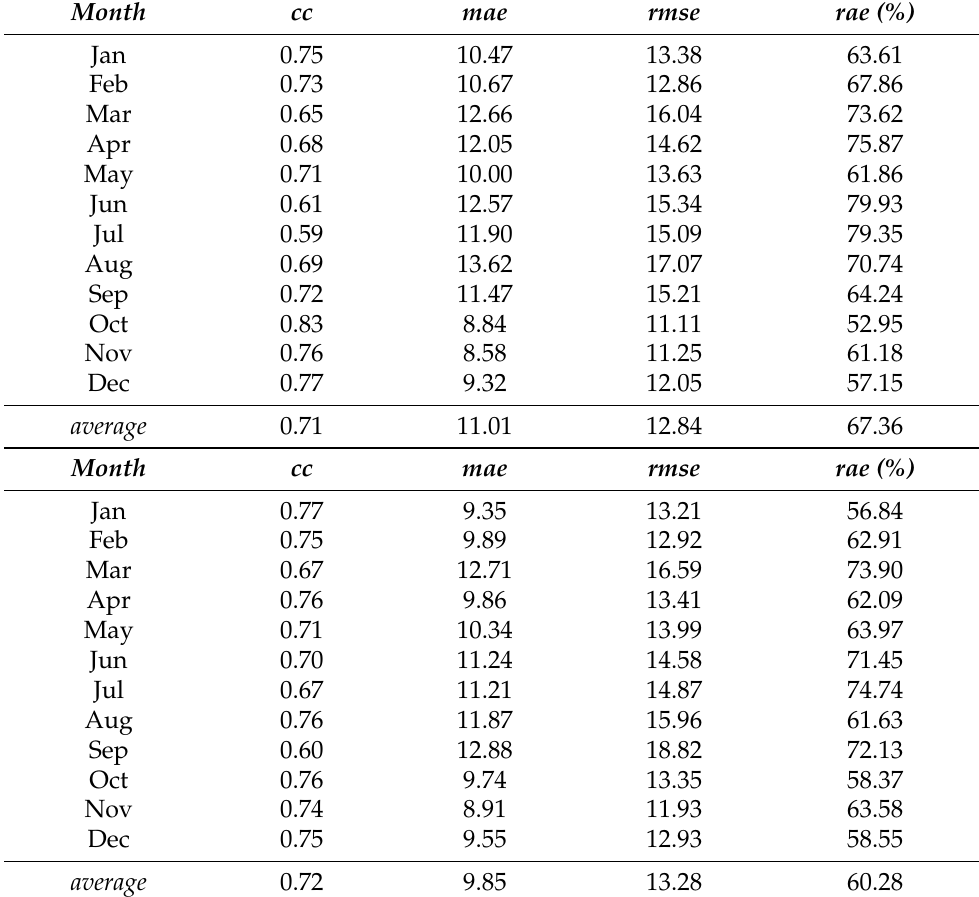
Table 3. Test results, non-temporal data: linear regression (top) and decision tree regression (bottom).